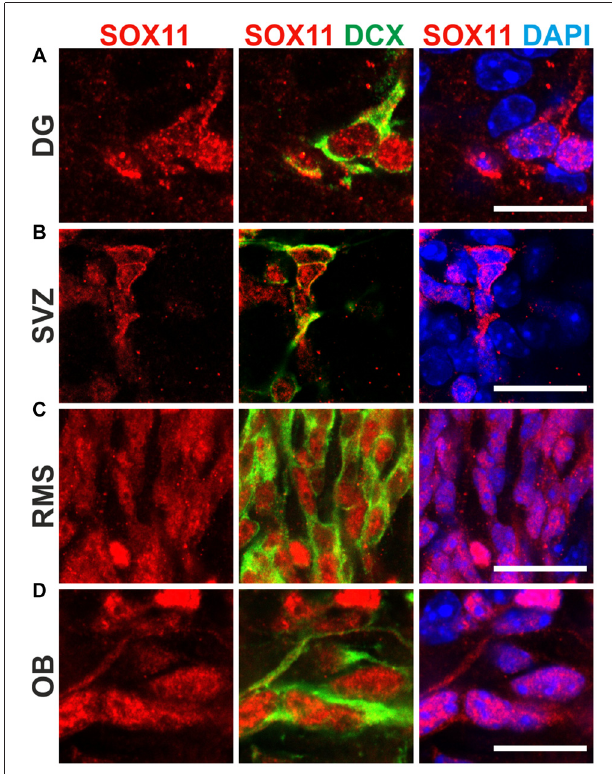
FIGURE 2 | SOX11’s subcellular localization in adult neurogenesis. Immunofluorescent analysis of SOX11’s subcellular localization in the dentate gyrus (DG; A) , the subventricular zone (SVZ; B) , the rostral migratory stream (RMS; C) and the olfactory bulb (OB; D) . SOX11 (red), DCX (green), DAPI (blue). Scale bars: 20 µ